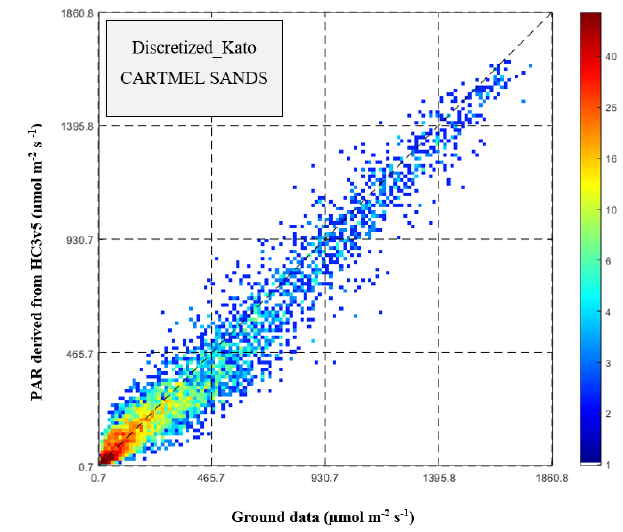
Figure 5. 2-D histogram of the PAR in-situ measurements (hori- zontal axis) and PAR derived from HC3v5 estimates using the Dis- cretized_Kato method (vertical axis) at Cartmel